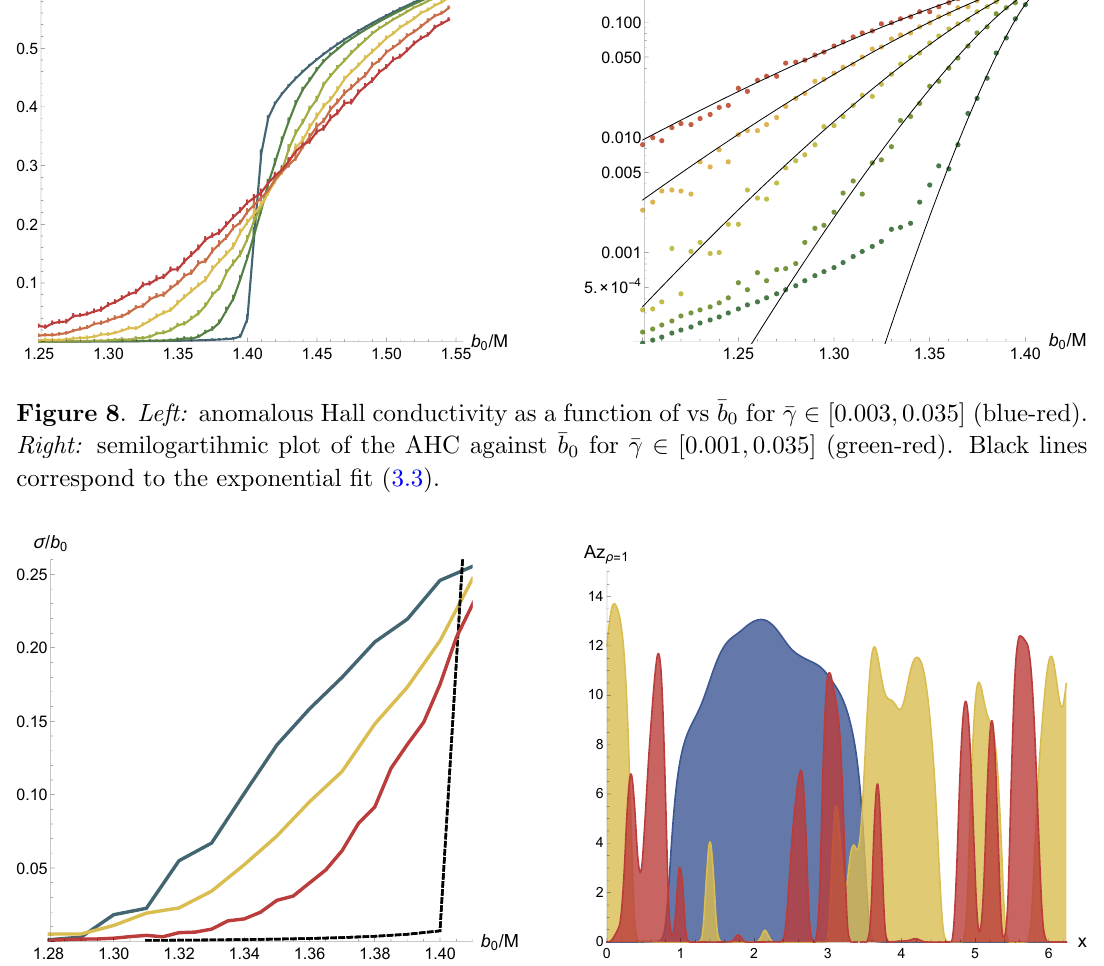
Figure 9 . Left: AHC close to the critical (cid:22) b 0 for (cid:12)xed P = 0 : 15 and M=T = 10 =(cid:25) and increasing correlation (cid:11) = 0 ; 0 : 5 ; 2 (red, yellow, blue). Black dashed line shows the AHC at zero disorder. Right: evolution of the rare regions with alpha for (cid:11) = 0 ; 0 : 5 ; 2 (red, yellow, blue) at (cid:12)xed P = 0 : 15. Localized regions become broader, as expected for increasingly correlated